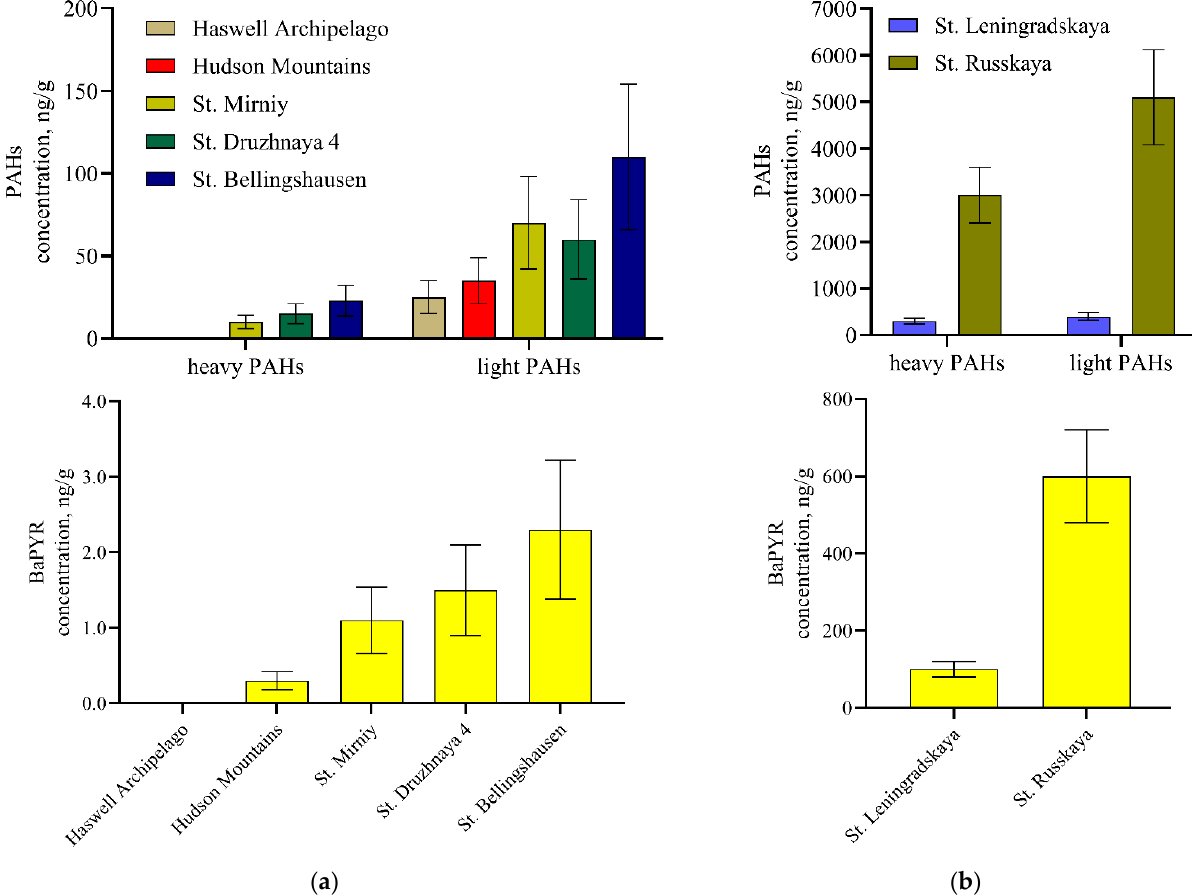
Figure 3. PAH fractions in Antarctica soils ( a ) and former agrosoils ( b ).